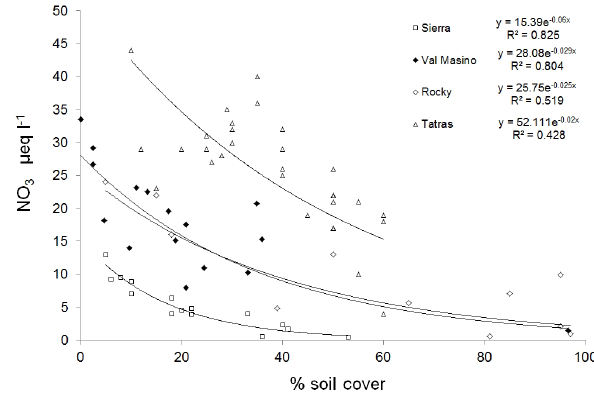
Fig. 8. Relationship between the mean NO 3 concentration in catch- ment outflow and soil cover for high-elevation watersheds of the Val Masino (present study), the Sierra Nevada, the Rocky Mountains and the Tatra Mountains (from Sickman et al., 2002, and Kopacek et al.,